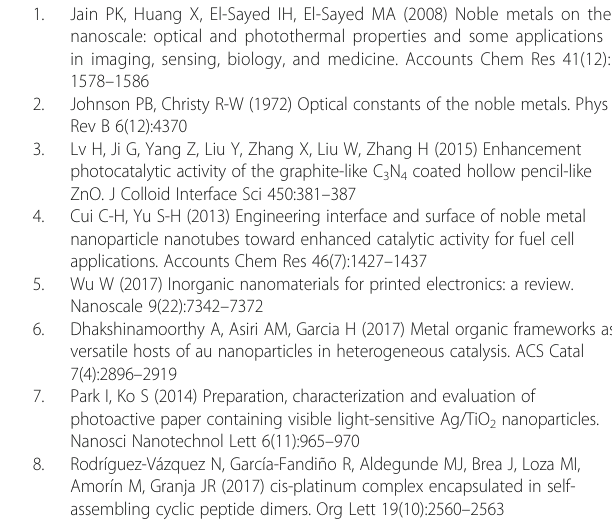
Additional file 1: Figure S1. (a) SEM image of Ag/Au/AgCl hollow heterostructures (S2). (b) The corresponding magnified SEM image, (c) SEM image of Ag/Au/AgCl hollow heterostructures (S3). (d) The corresponding magnified SEM image. Figure S2. Time-dependent UV-vis spectrum of Nip with (a) 0.025 mg and (b) 0.1 mg of Ag NWs. Figure S3. Time-dependent UV-vis spectrum of Nip with (a) 0.025 mg of S1 and (b) 0.025 mg of S3. (DOCX 1439